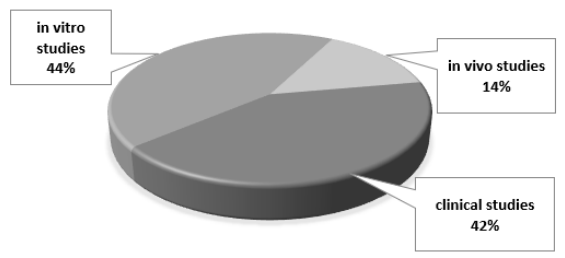
Materials 2021 , 14 , x FOR PEER REVIEW Figure 3. Articles distribution in clinical/in vitro/in vivo studies in periodontal regeneration with BGs, from 2006 to 2021.